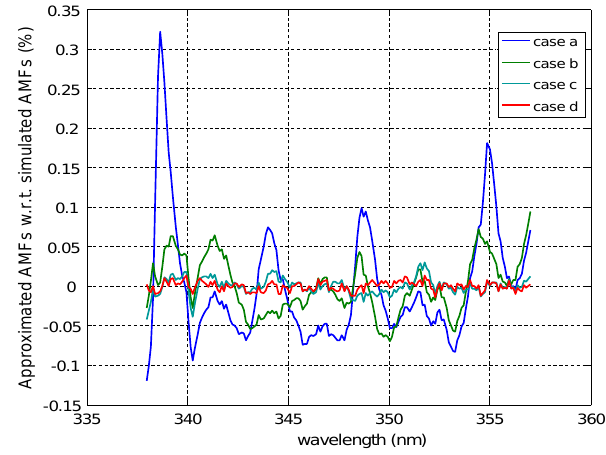
Fig. A1. Relative difference between AMFs of ozone approximated by Taylor series and simulated AMFs for the main settings (see Ta- ble 1). Different lines correspond to results obtained by considering different number of Taylor series terms as fit parameters as listed in Table A1. The difference is averaged for all tangent heights. Com- pare with Fig. 1 to see the improvement with respect to a constant